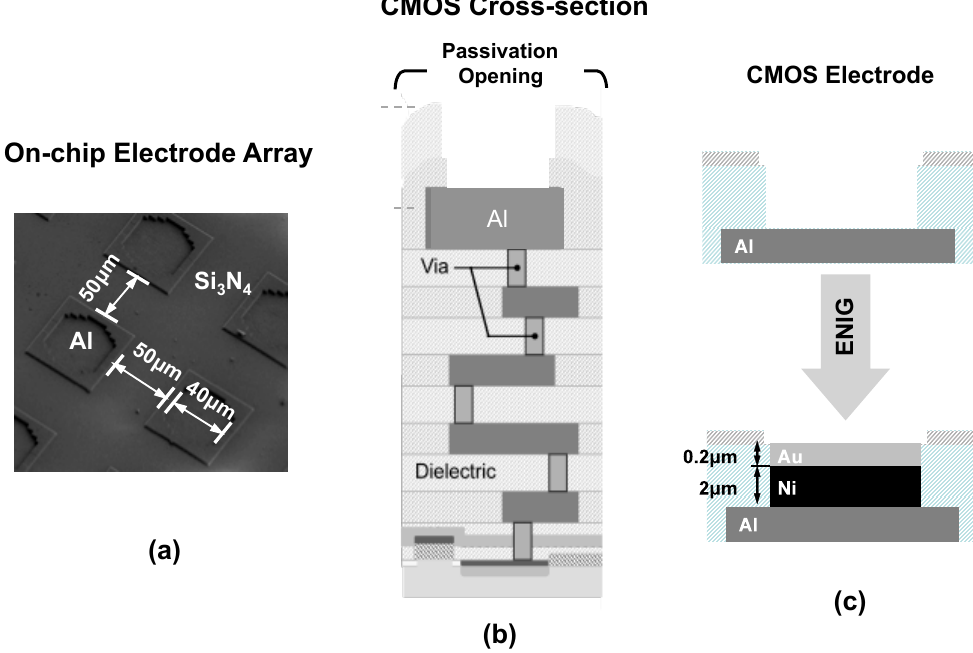
Figure 4. ( a ) SEM cross section of the on-chip electrode array ( b ) Cross section of CMOS process ( c ) CMOS electrode and post-processing modification with